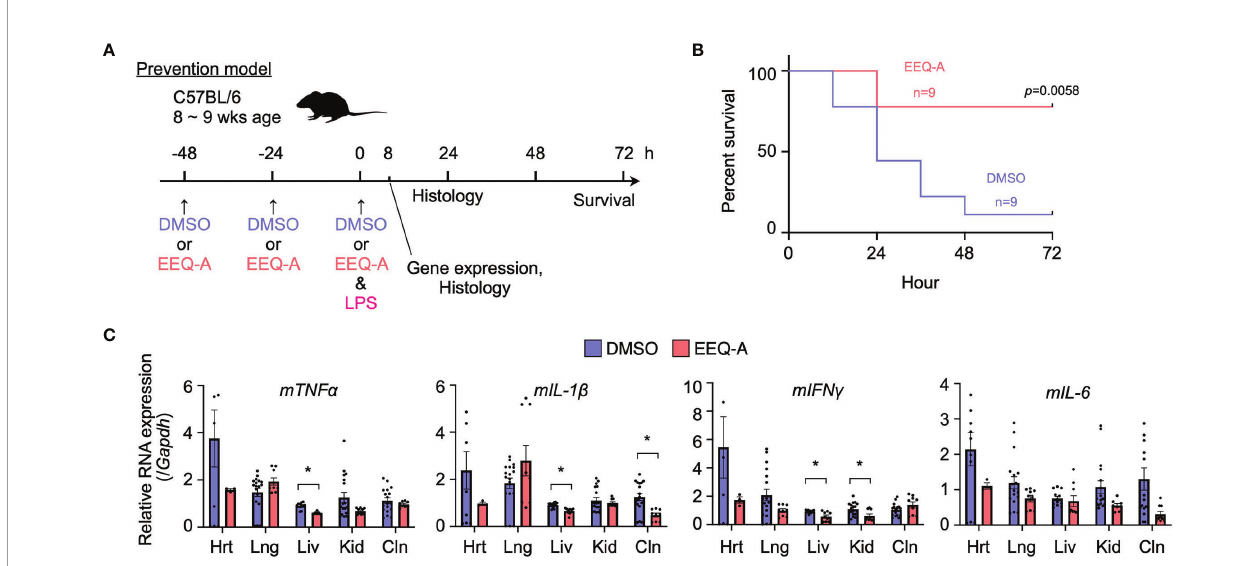
FIGURE 1 | (A) Prevention protocol. (B) Kaplan – Meier survival curve of mice subjected to the prevention protocol. (C) The mRNA expression of proin fl ammatory cytokines in mice subjected to the prevention protocol at 8 hours after LPS administration. Hrt, Heart; Lng, Lung; Liv, Liver; Kid, Kidney; Cln, Colon. The p-value at 72 hours is shown. *0.0001 to